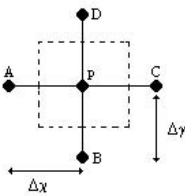
Figure 1: Vectors geometry with respect to the contour of the conductor.